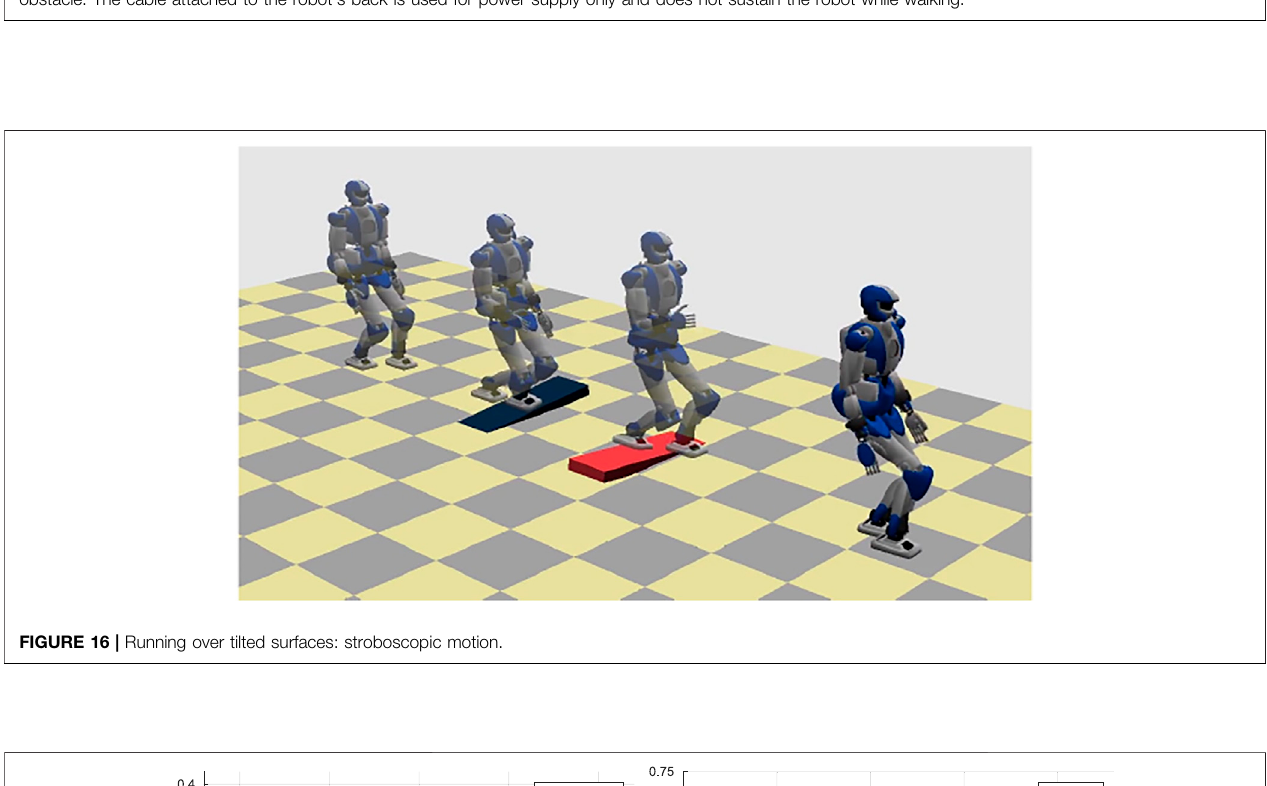
Frontiers in Robotics and AI |